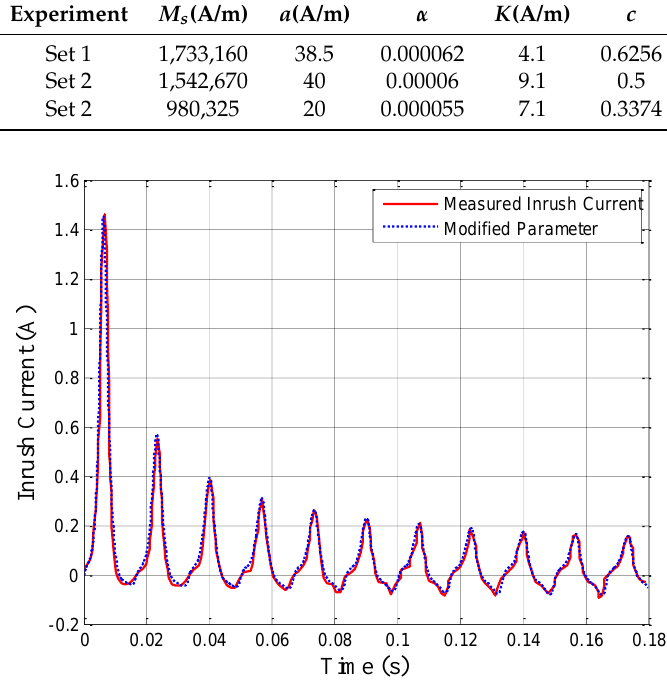
Figure 8. Inrush current simulation by the automatic